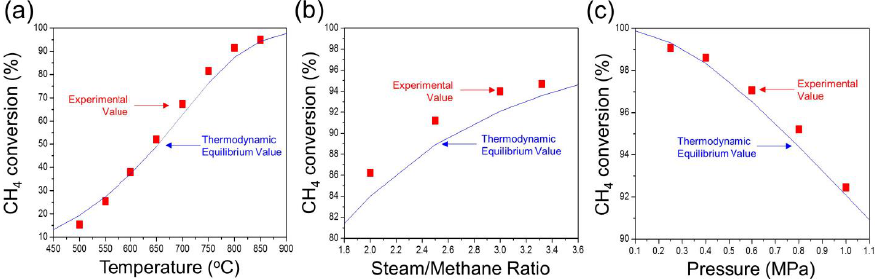
Figure 1. E ff ect of ( a ) reaction temperature, ( b ) steam / methane ratio, and ( c ) reaction pressure on methane conversion in the lab-scale reactor.